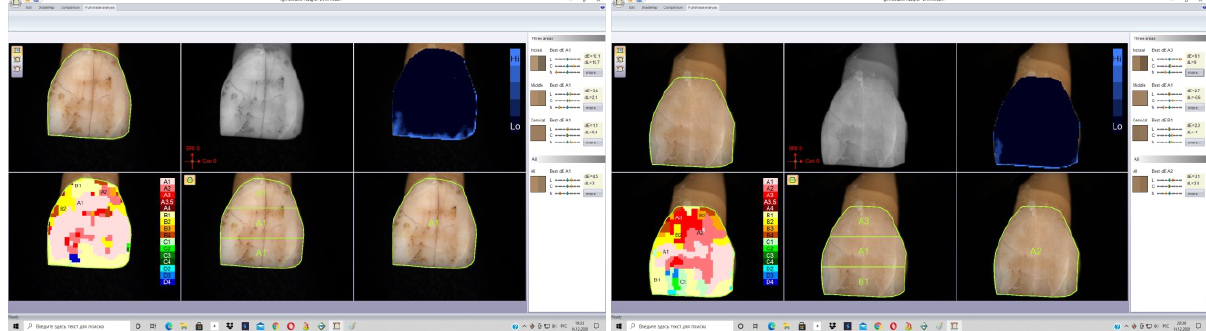
Figure 4. Shade mapping on dry tooth 2.1 from skull VIII-7-2. Figure 5. Shade mapping on drench tooth 2.1 from skull VIII-7-2.